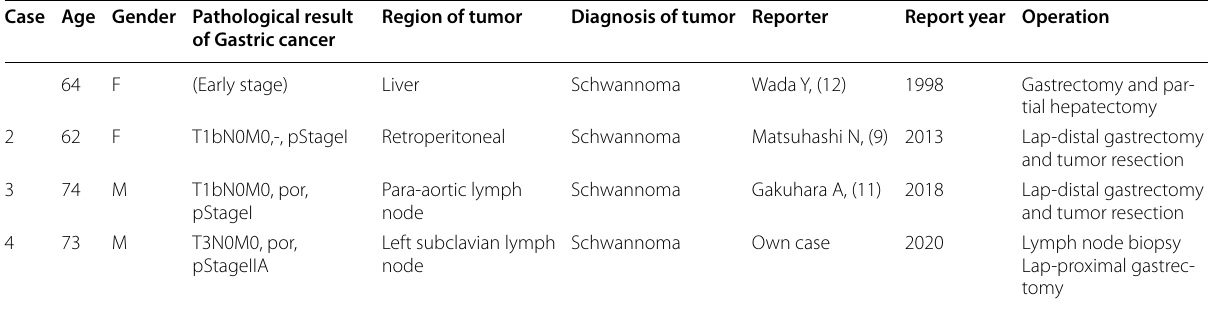
Lap Laparoscopic